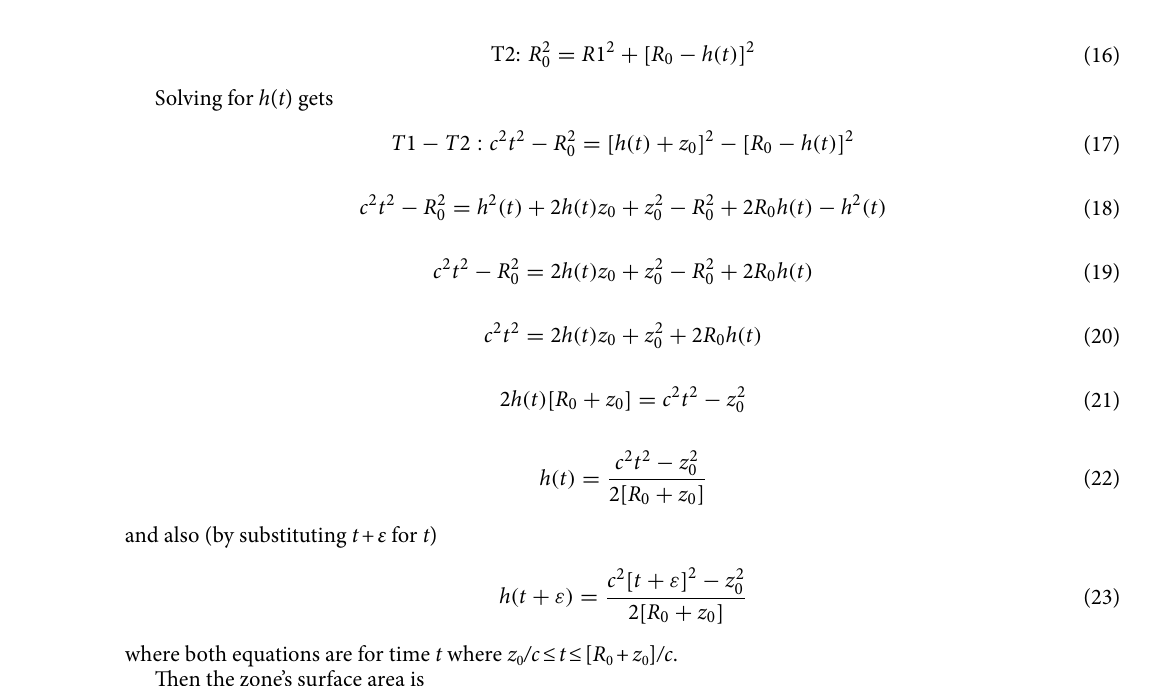
Figure 5. Non expanding spherical shell impulsive source. ( a ) A spherical cap on an impulsive spherical shell source. (The spherical shell may be referred to as a ’sphere’ hereafter.) The radius is R 0 , and the sphere is centered at the coordinate origin and has impulsive excitation δ f ( t ). Each point on the sphere’s surface represents a point source which radiates an impulsive spherical wavelet. The parameter z 0 is the radial distance from the sphere’s surface to the point in space, P , at which the resultant wave field φ will be observed as a function of time. The propagation speed is c . The distance ct from P to a point on the sphere defines a spherical cap of height h ( t ) with radius R 1. The sphere is transparent to radiation so that the whole sphere will contribute to the wave field at any one point in space. ( b ) The locus of all contributing radiating points is a spherical zone. These are the only points on the spherical source of radius R 0 which can contribute to the field at P during the time interval [ t , t + ε ] and at distance z 0 from the sphere. The zone on the spherical source is bounded by its intersection with two concentric spheres of radius ct and radius c [ t − ε ] centered at the field point P . The intersections defines spherical caps of heights h ( t ) and h ( t + ε ), also radii R 1 and R